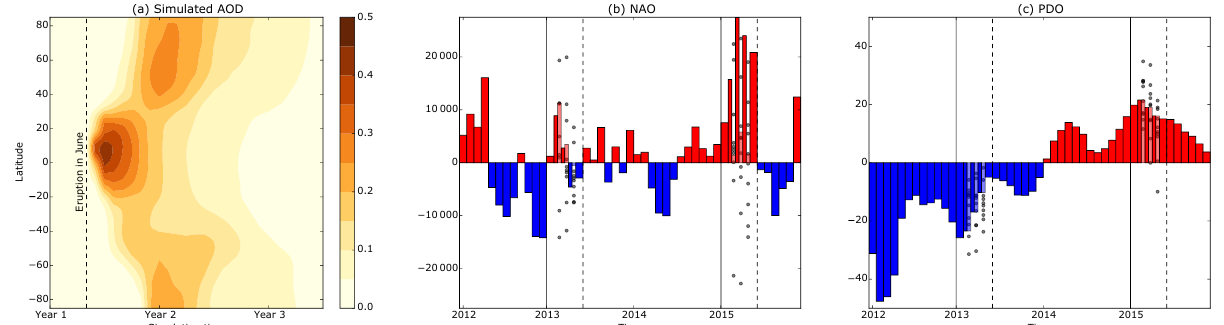
Figure 1. (a) Temporal evolution of the stratospheric aerosol optical depth (AOD) used for our simulations with a Pinatubo-like eruption. The climate indices NAO (b) and PDO (c) calculated from the assimilation model run. Lighter colors are the indices of the prediction system ensemble mean before the Pinatubo-like eruption and grey circles are the individual ensemble members. Vertical lines indicate the initialization time of our forecast experiments and vertical hatched lines indicate the start of the Pinatubo-like